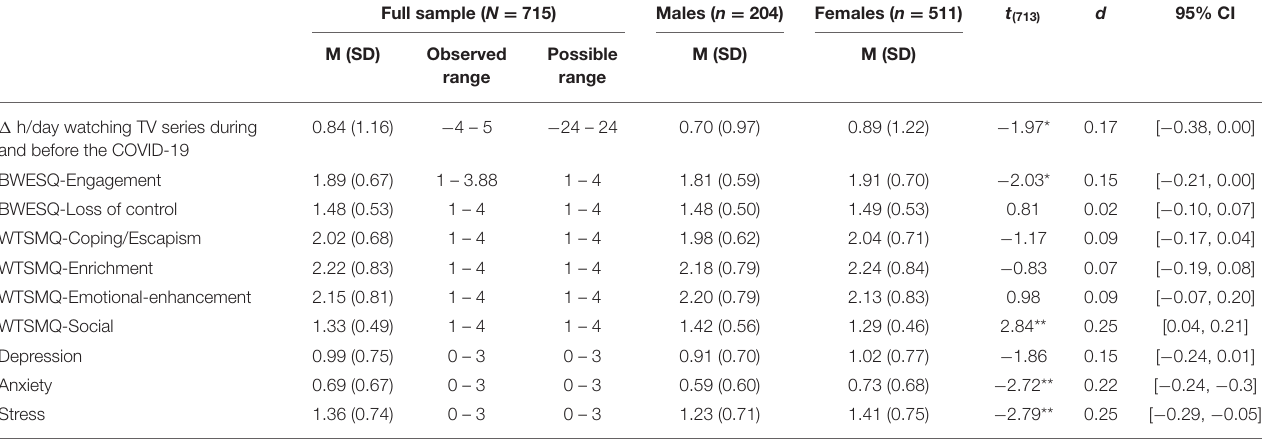
TABLE 1 | Descriptive statistics and gender differences for all investigated variables.